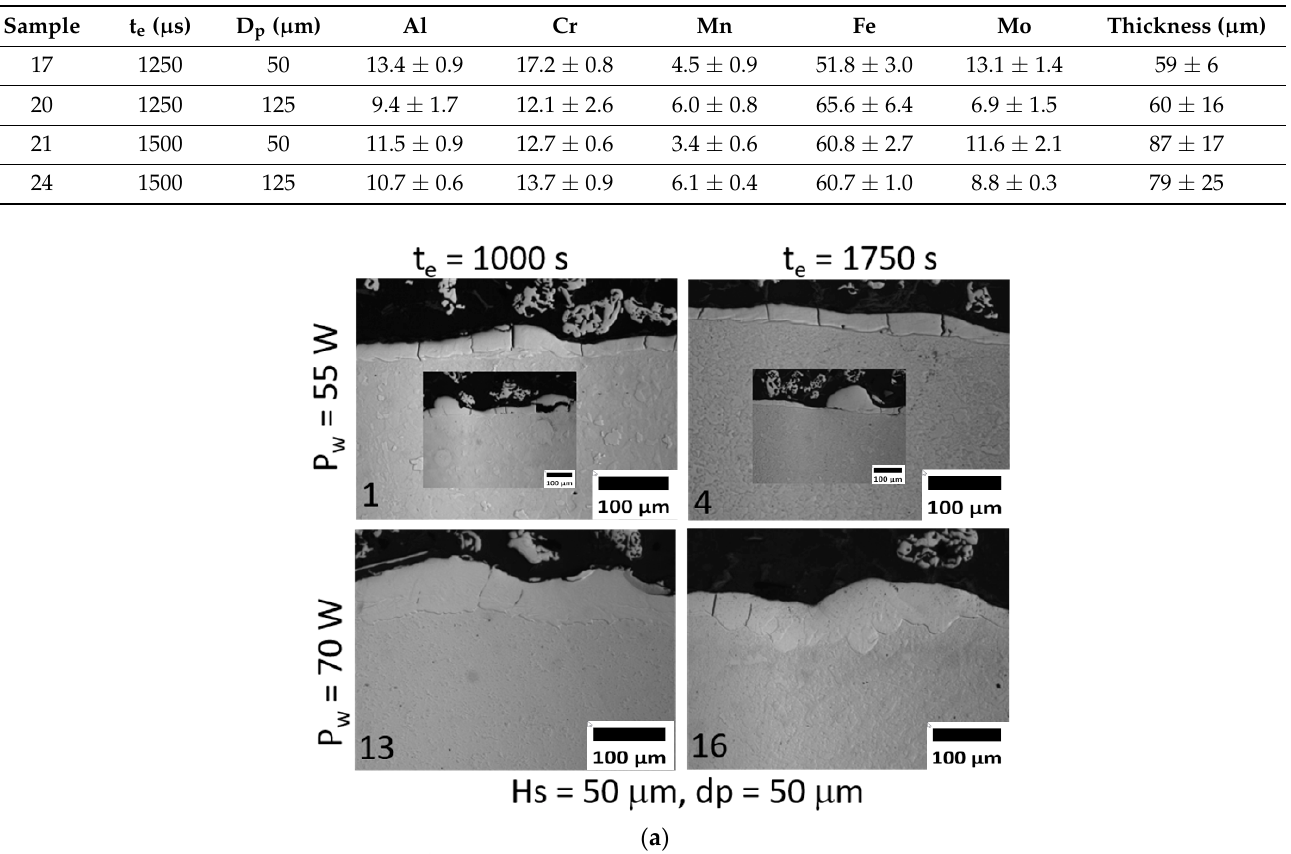
Table 3. Results of chemical composition by EDS and thickness of coatings deposited with H s of 100 µm and Pw of 75 W.